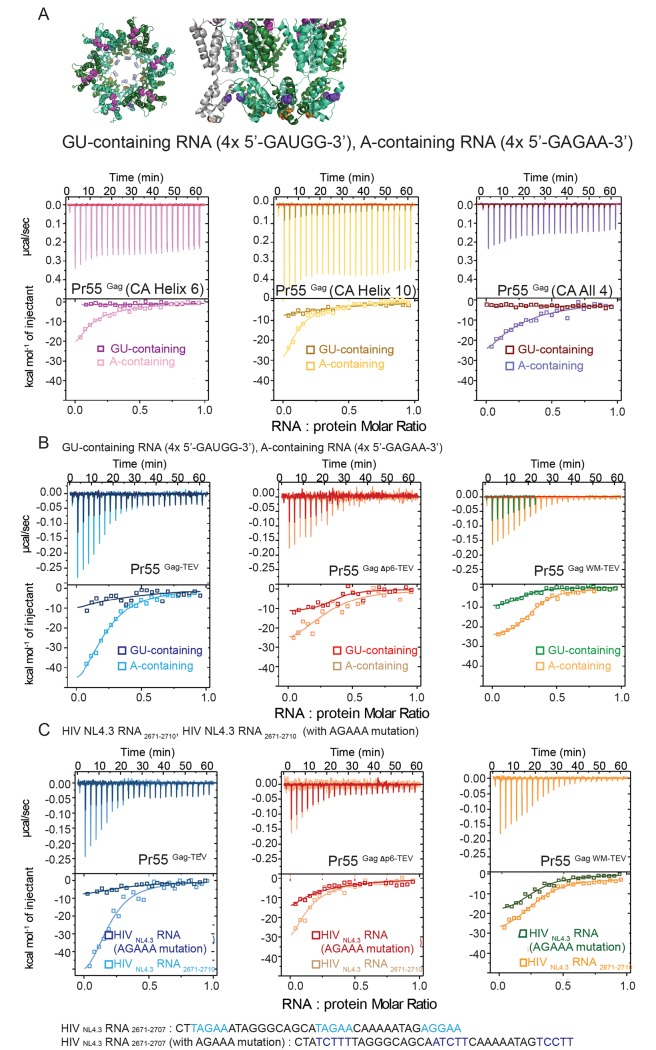
Favourable interaction energetics between high-order Pr55Gag oligomers and Adenosine-containing RNA persists with authentic HIV A-containing sequences.(A) On the left is a top-down view of the published immature Pr55Gag capsid hexamer cryo-EM structure (PDB ID:4usn) [32]. Intra-hexameric subunits are coloured in alternating green-cyan and dark green. Helix6 mutations (TTSTLQ 239–44 AASALA) disrupting intra-hexameric interactions of the NTD-capsid are shown as spheres and coloured in magenta. Helix10 mutation (D329A) and MHR mutation (K290A) disrupting intra-hexameric interactions of the CTD-capsid are shown as spheres and coloured in orange and blue-white, respectively. On the right is the side view of immature Pr55Gag capsid. The WM mutation (WM316-7AA) disrupting inter-hexameric dimerization is highlighted in blue. Pr55Gag (CA All 4) contains 4 sets of mutations that disrupt CA oligomerization (Helix6, Helix10, WM and MHR) [28]. ITC binding curves indicating heat released per mole of oligonucleotide titrated when 40 μM of 4x 5’-GAUGG-3’ (GU-containing) and 4x 5’-GAGAA-3’ (A-containing) RNA were injected in 1.5 ul aliquots into 8 μM of Pr55Gag (CA Helix 6) (Fig 6A left panel, dark pink and light pink), Pr55Gag (CA Helix 10) (Fig 6A middle panel, dark yellow and light yellow), and Pr55Gag (CA All 4) (Fig 6A right panel, red-brown and purple). (n = 3) (B) Representative ITC binding curves indicating heat released per mole of oligonucleotide titrated when 40 μM of 4x 5’-GAUGG-3’ (GU-containing) and 4x 5’-GAGAA-3’ (A-containing) RNA were injected in 1.5 ul aliquots into 8 μM of Pr55Gag-Tev (Fig 6B left panel, dark blue and light blue), Pr50Gag Δp6-TEV (Fig 6B middle panel, dark orange and light orange), and Pr55Gag WM-TEV (Fig 6B right panel, green and dark yellow). (n = 3) (C) Representative ITC binding curves indicating heat released per mole of oligonucleotide titrated when 40 μM of 5’- CTTAGAAATAGGGCAGCATAGAACAAAAATAGAGGAA-3’ (HIVNL4.3RNA2671-2710) and 5’- CTATCTTTTAGGGCAGCAATCTTCAAAAATAGTCCTT-3’ (HIVNL4.3RNA2671-2710 with AGAAA mutation) RNA were injected in 1.5 ul aliquots into 8 μM of Pr55Gag-Tev (Fig 6C left panel, dark blue and light blue), Pr50Gag Δp6-TEV (Fig 6C middle panel, dark orange and light orange), and Pr55Gag WM-TEV (Fig 6C right panel, green and dark yellow). (n = 3)